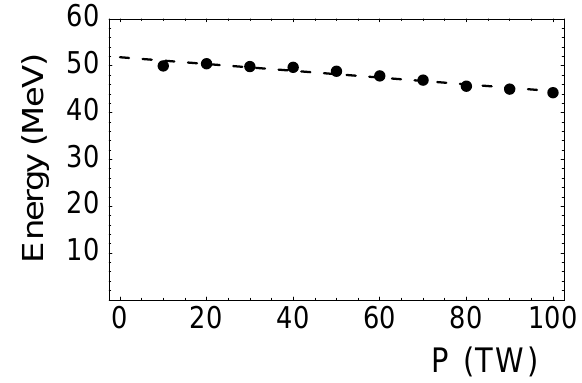
FIG. 10. Trapped charge after 2.7 mm acceleration for differ- ent bunches (see text), as a function of peak power. Dots are simulation results; the dashed line is a linear fit through (cid:1) 0, 0 (cid:2) .